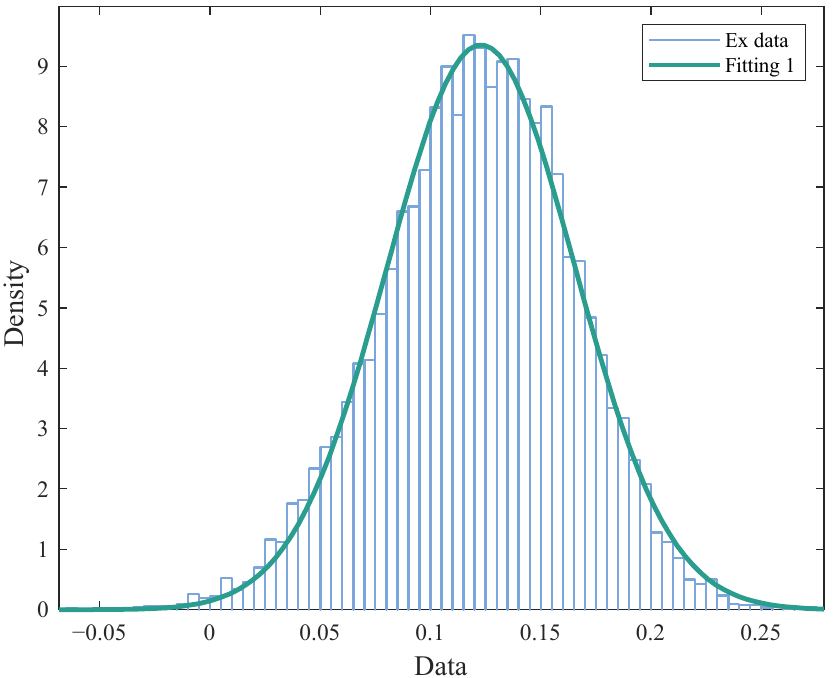
Figure 5. Cloud parameter simulation diagram in SOP.